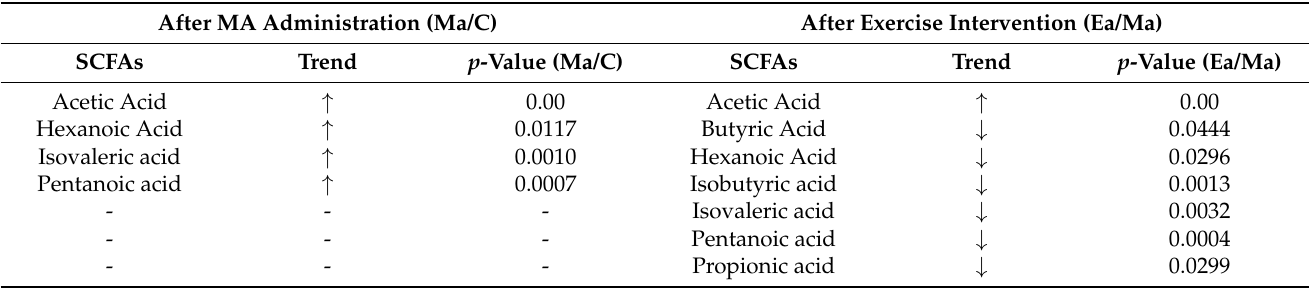
Table 3. The relationship between the changes in SCFAs levels among the three groups of